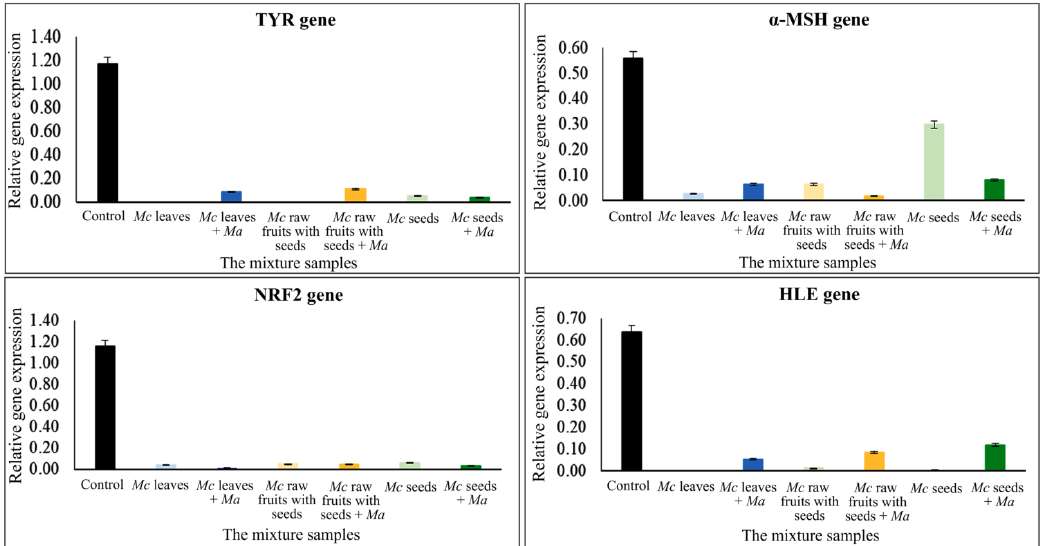
Figure 6. Inhibition gene expression values and the mixture of plant parts with various concentrations of Morinda citrifolia (Mc) containing α -EG and pinoresinol, and Morus alba (Ma) leaves containing 20.48 g total protein per 100 g at a concentration of 3.11 mg/mL. Table 5. Comparative values of inhibition expression with and without Morus alba (Ma) protein extract added to Morinda citrifolia (Mc) parts containing α -EG and pinoresinol.